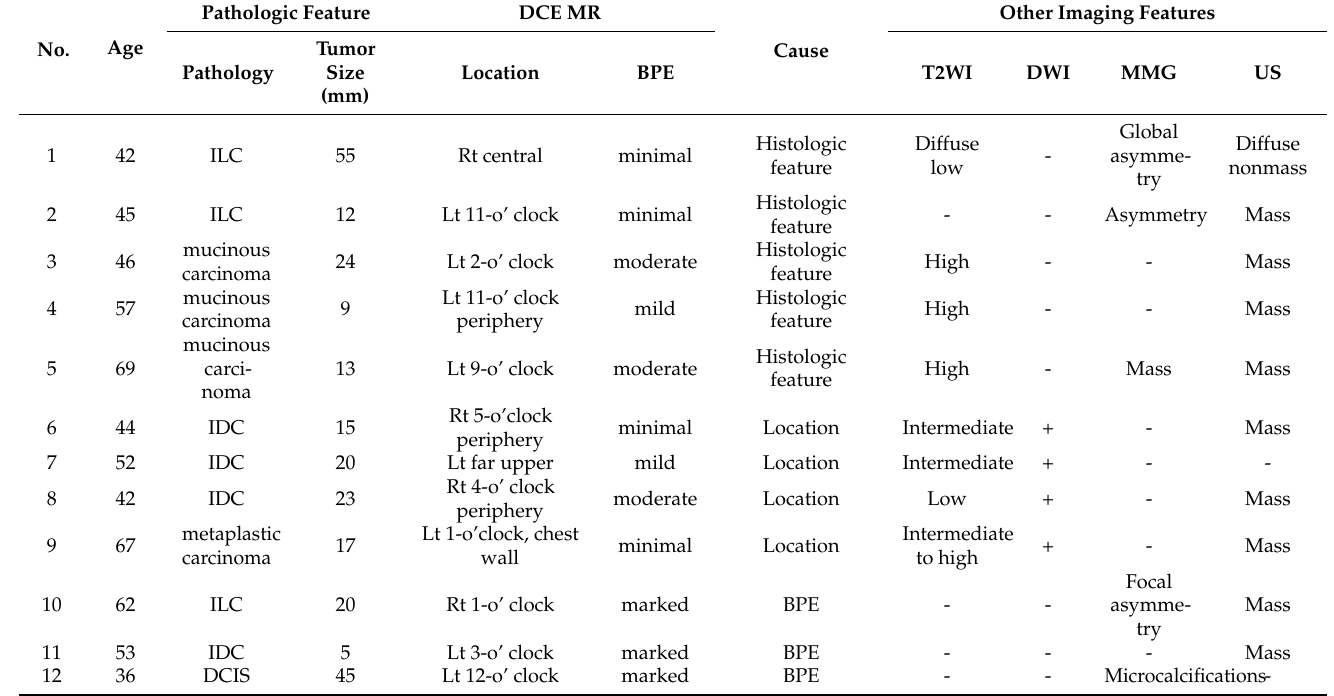
Table 2. Imaging features and histology of not-detected breast malignancy in DCE